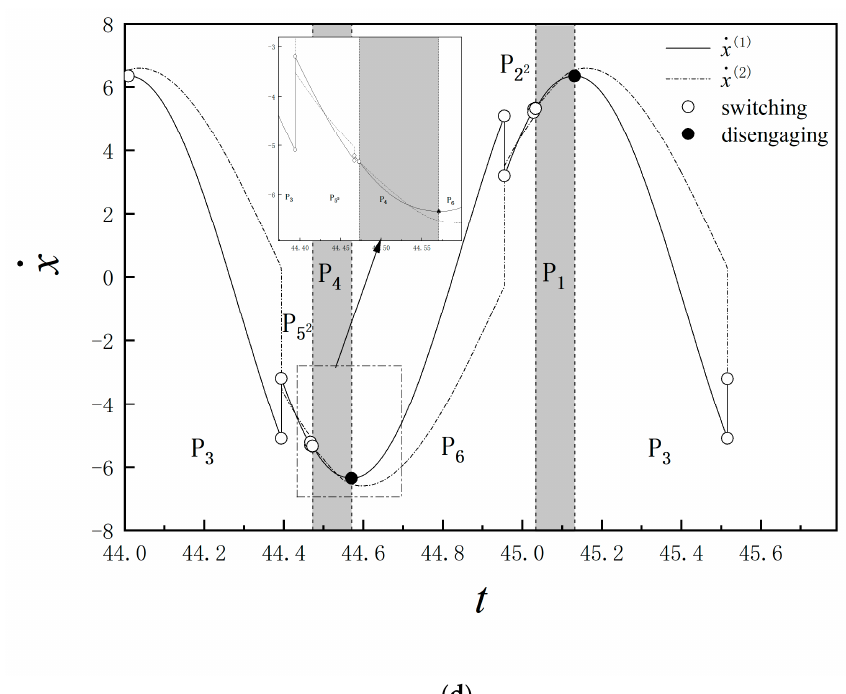
Figure 9. Phase plane of the gear motion at e = 0.06. ( a ) Phase plane of gear 1, ( b ) Phase plane of gear 2, ( c ) Displacement‑time diagram, ( d ) Velocity‑time